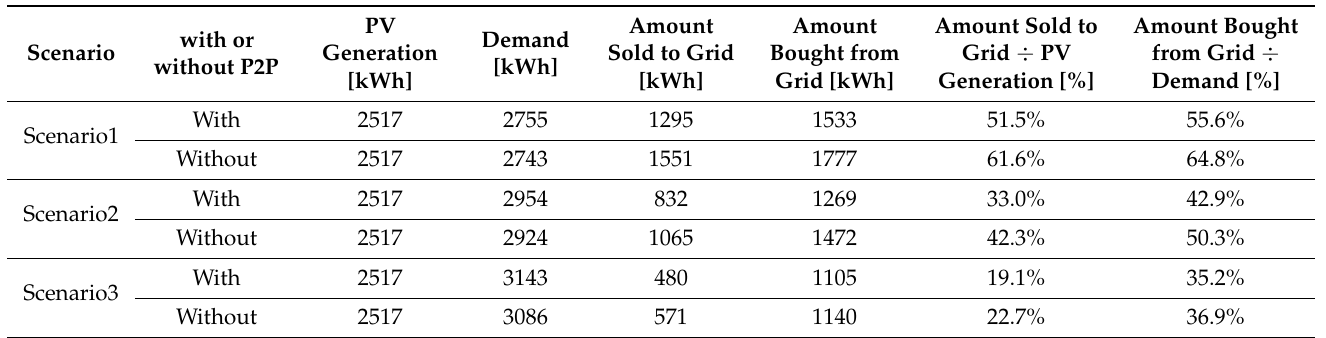
Table 7. The supply and demand of electricity throughout the community.